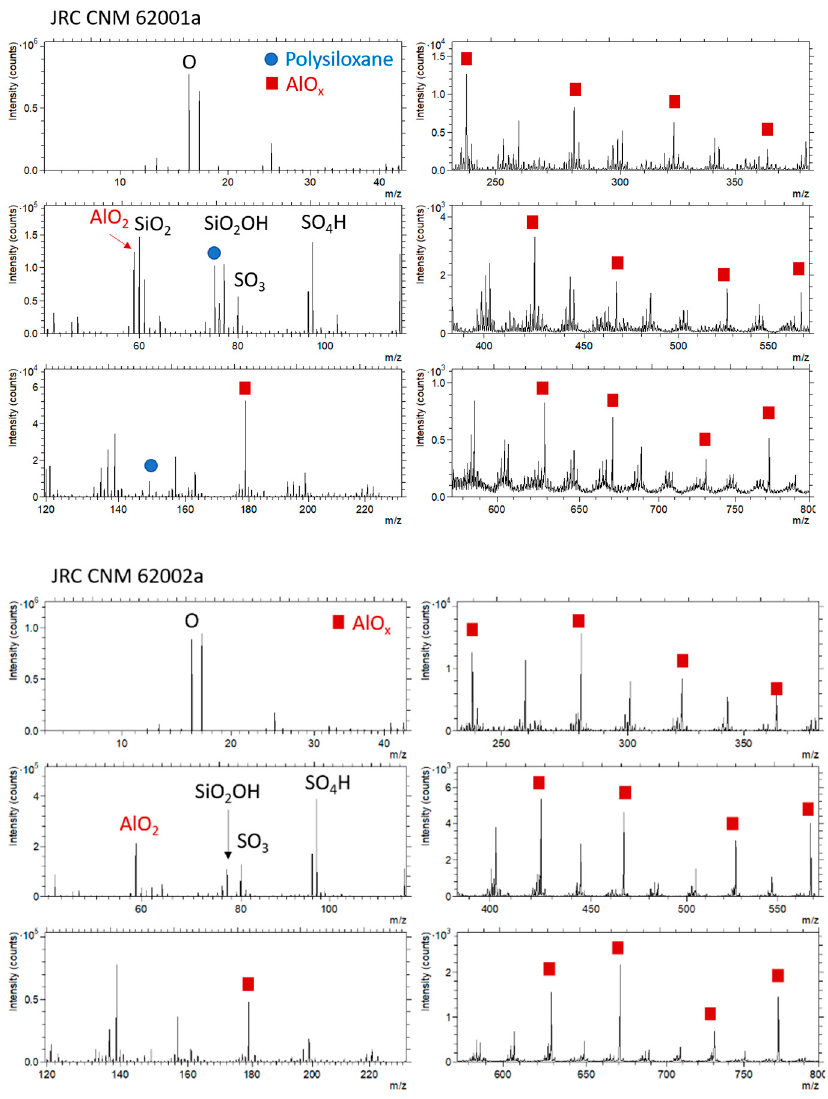
Figure 8. ToF-SIMS spectra, negatively charged secondary ions (top: JRCNM 62001a, bottom, JRCNM 62002a); field of view: 325 × 325 µm².